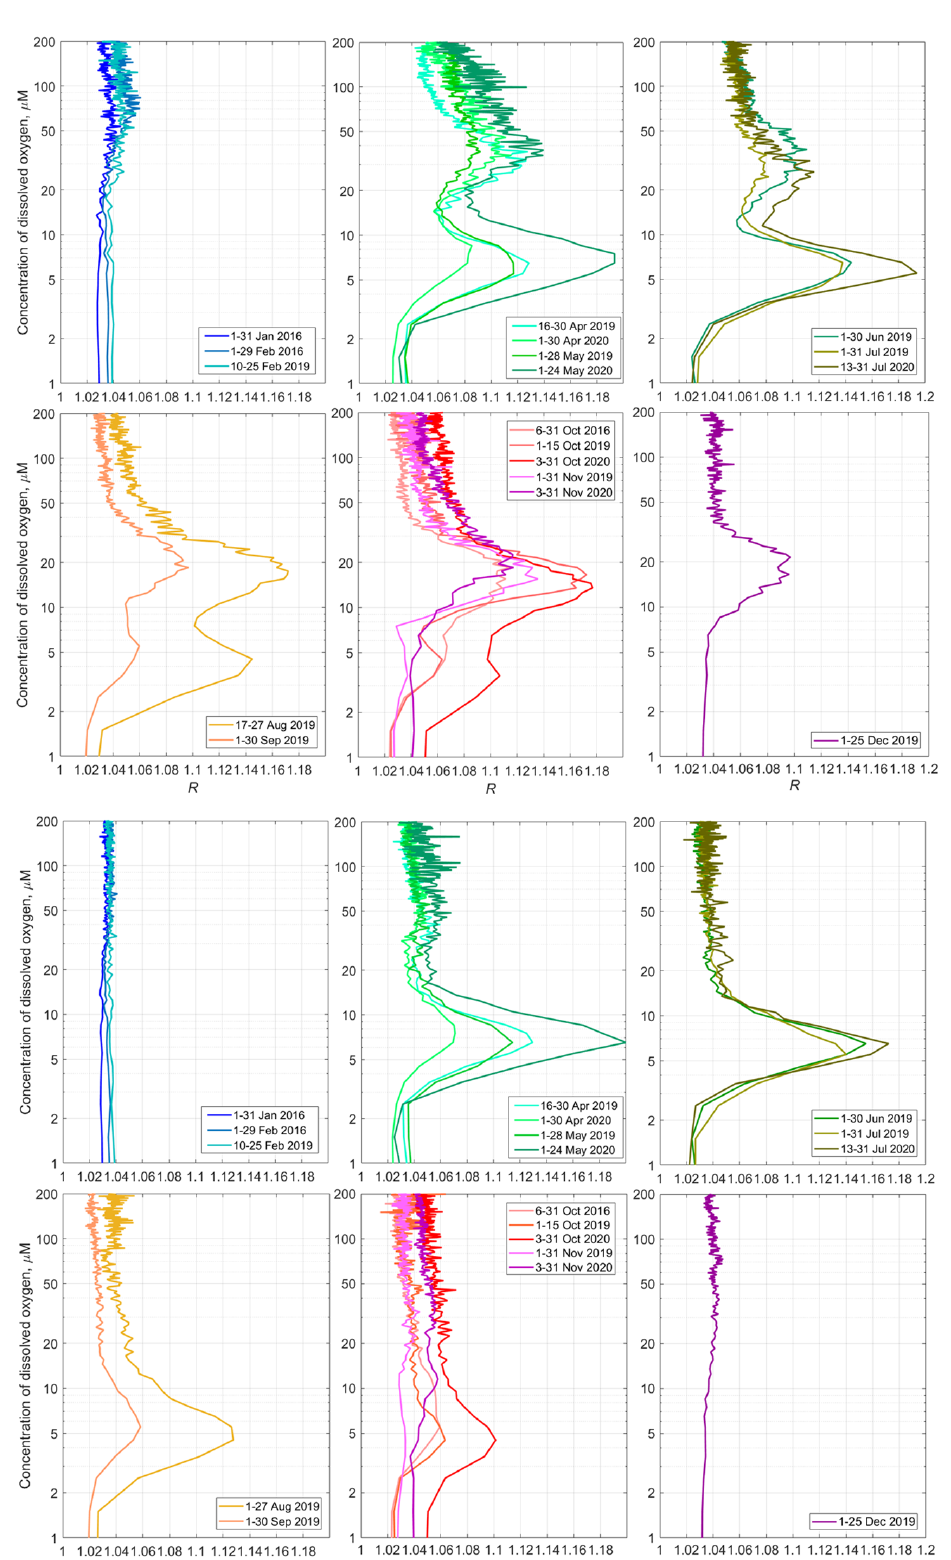
Figure 14. Top – the monthly averaged profiles of (cid:104) R( [ O 2 ] ) (cid:105) for the daytime over the upper part of the continental slope near Gelendzhik in the NE Black Sea. Bottom – the same for the